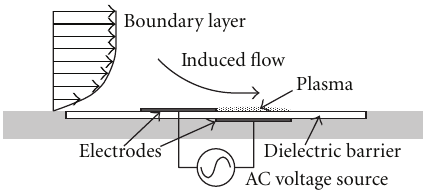
Figure 1: Schematics of plasma actuator.